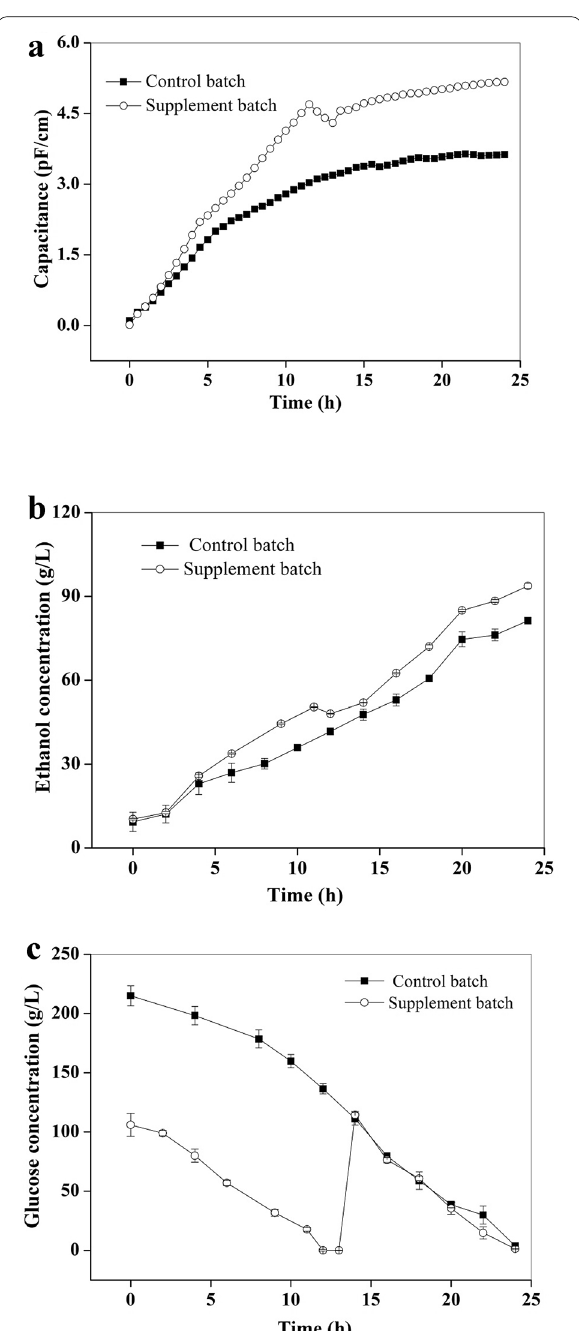
Fig. 6 Variation curves of capacitance ( a ), ethanol production ( b ) and glucose consumption ( c ) during 5-L fermentation under the conditions of control batch and supplement batch